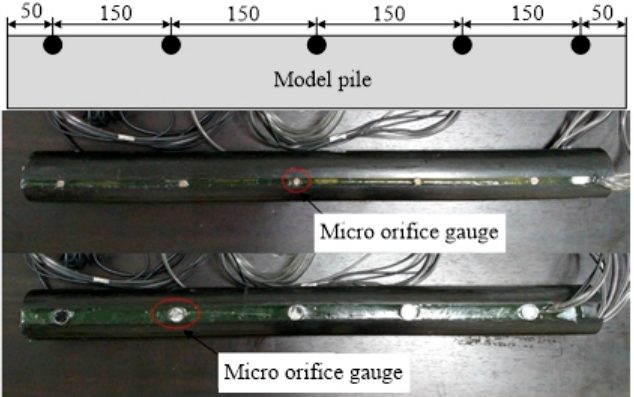
Figure 5. Positions of the micro earth and pore water pressure sensors and photographs after the encapsulated of the micro earth and pore water pressure sensors.